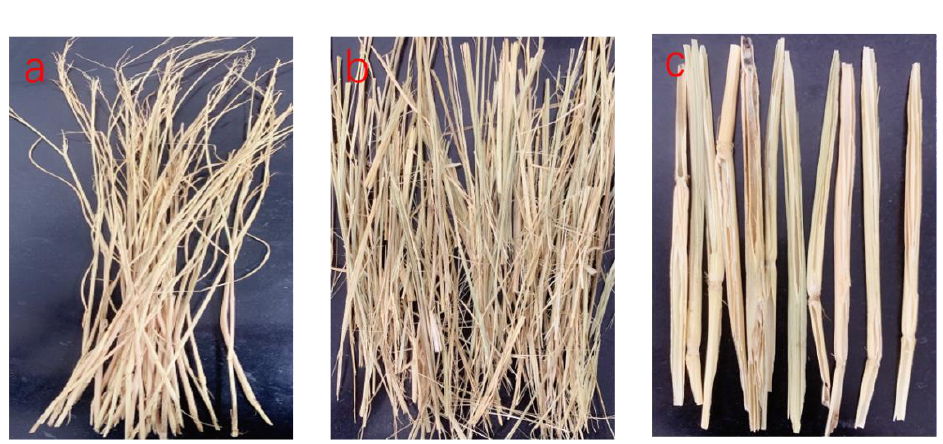
Figure 1. Process of preparing the straw composite.